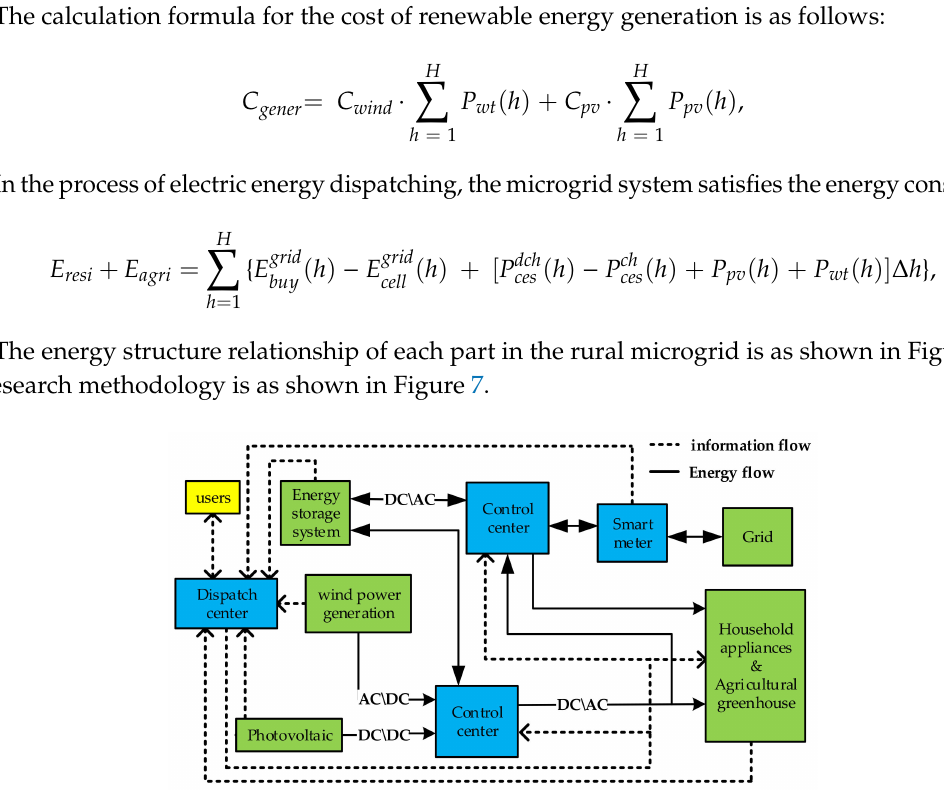
Figure 6. Rural microgrid energy system structure diagram.